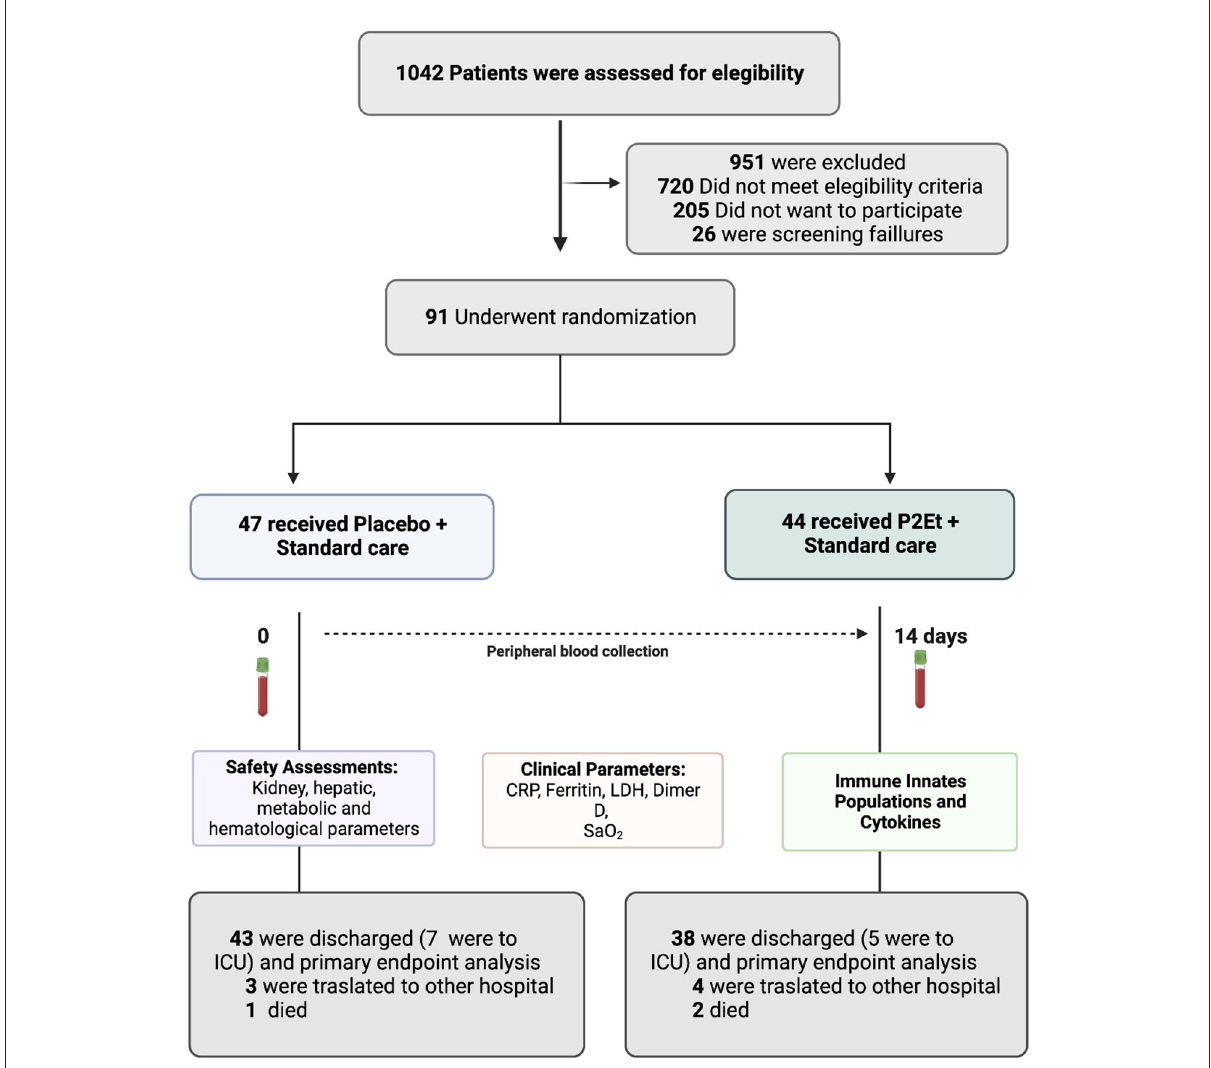
FIGURE1 Screening, Randomization, and Outcomes. COVID-19 patients were included in the study. 1,042 patients were screened and 91 patients underwent randomization. 47 patients received placebo and 44 patients received P2Et extract. A blood sample was taken from each patient before and after treatment to assess safety parameters, clinical parameters, immune innate cell populations by flow cytometry and cytokines for a MAGPIX ® System. This figure was created using BioRender (https://Biorender.com/).